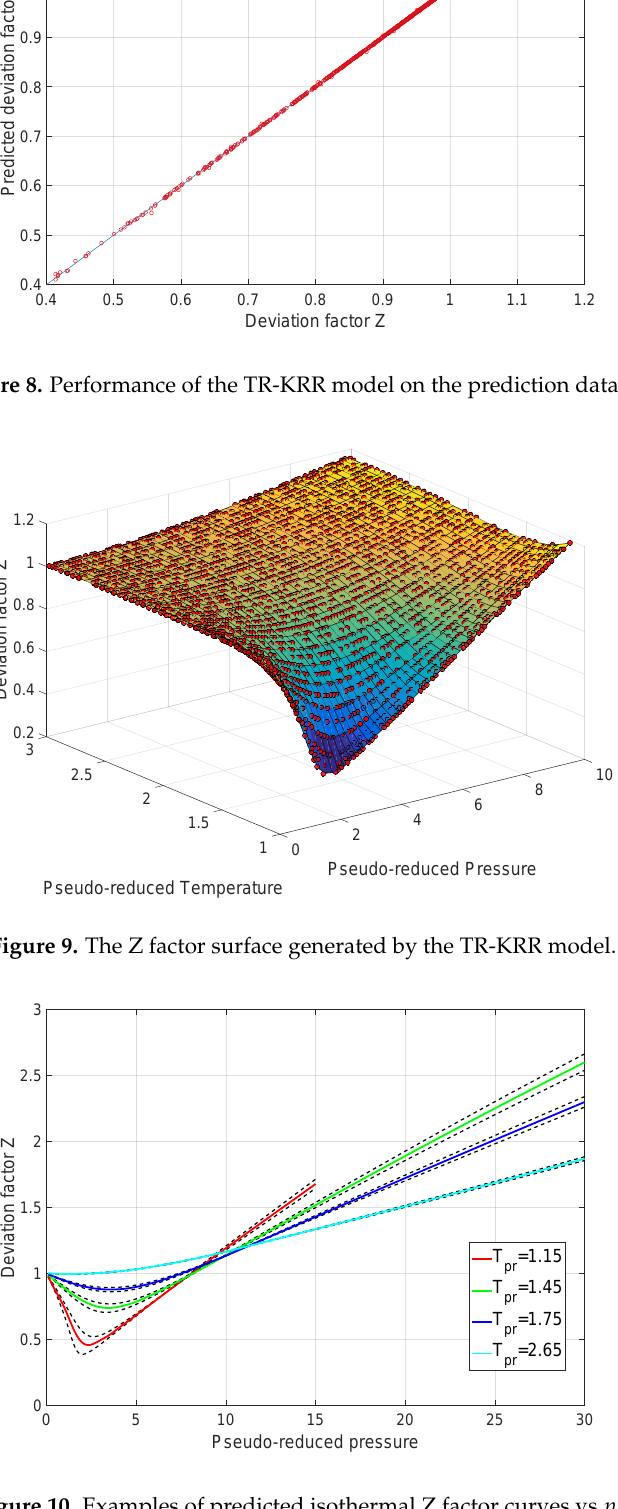
Figure 10. Examples of predicted isothermal Z factor curves vs p r